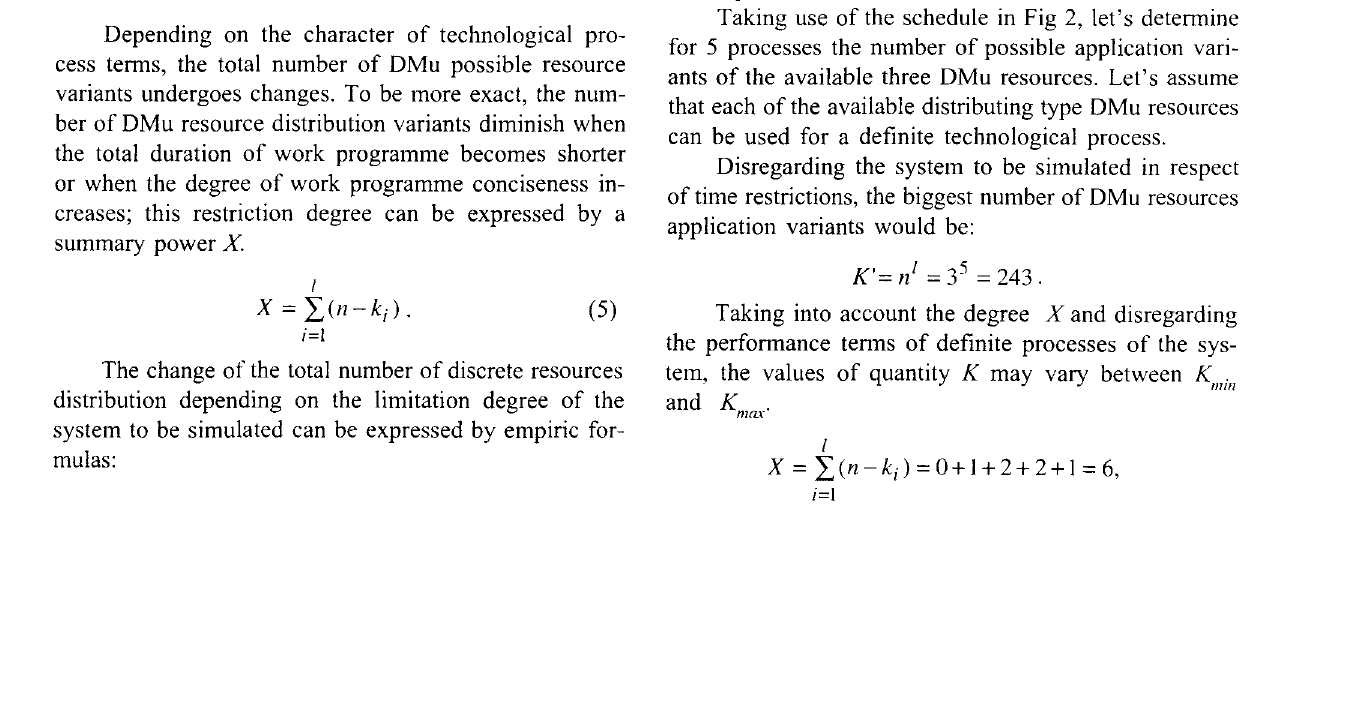
Fig 3. Relation between the number of variants K discre tional resource distribution and restriction degree X of simulation system, when n = 3 and I = 6 5. The influence of system restriction degree on the search for rational DMu resource application vari ants When decreasing the restriction degree of the sys tem to be simulated, the number of DMu resource appli cation variants increases and at the same time more favourable conditions for the search for rational variant